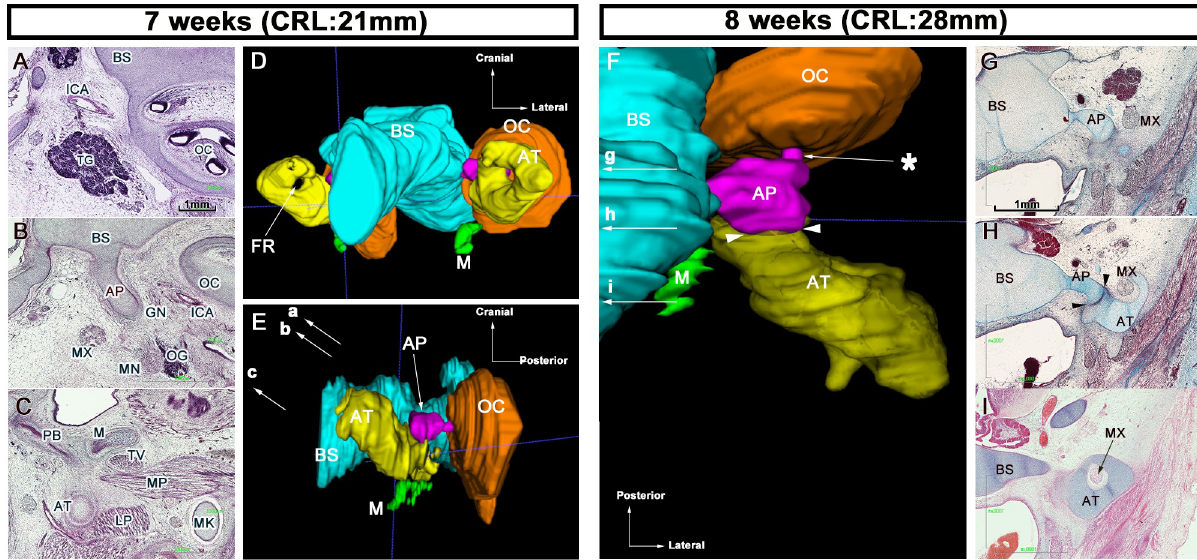
Fig 1. Sphenoid development at 7 and 8 WD. (A-C) Transverse sections at 7 WD. The AP was continuous with the basisphenoid. (D and E) 3D reconstructions at 7 WD. (F) 3D reconstruction at 8 WD. (D) Anterior view, (E) lateral view, and (F) superior view. (G–I) Frontal sections at 8 WD. Arrows (a–c) in (E) correspond to sections in (A–C), respectively. Arrows (g–i) in (F) correspond to sections in (G–I), respectively. (A–C) and (G–H) are obtained at the same magnification. Color code: blue, BS; pink, AP; yellow, AT; green, M; orange, OC. AP, alar process; AT, ala temporalis; BS, basisphenoid; GN, greater petrosal nerve; ICA, internal carotid artery; LP, lateral pterygoid muscle; M, medial pterygoid process; MK, Meckel’s cartilage; MN, mandibular nerve; MX, maxillary nerve; OC, otic capsule; OG, otic ganglion; PB, palatine bone; TG, trigeminal ganglion; TV, tensor veli palatine; WD, weeks of